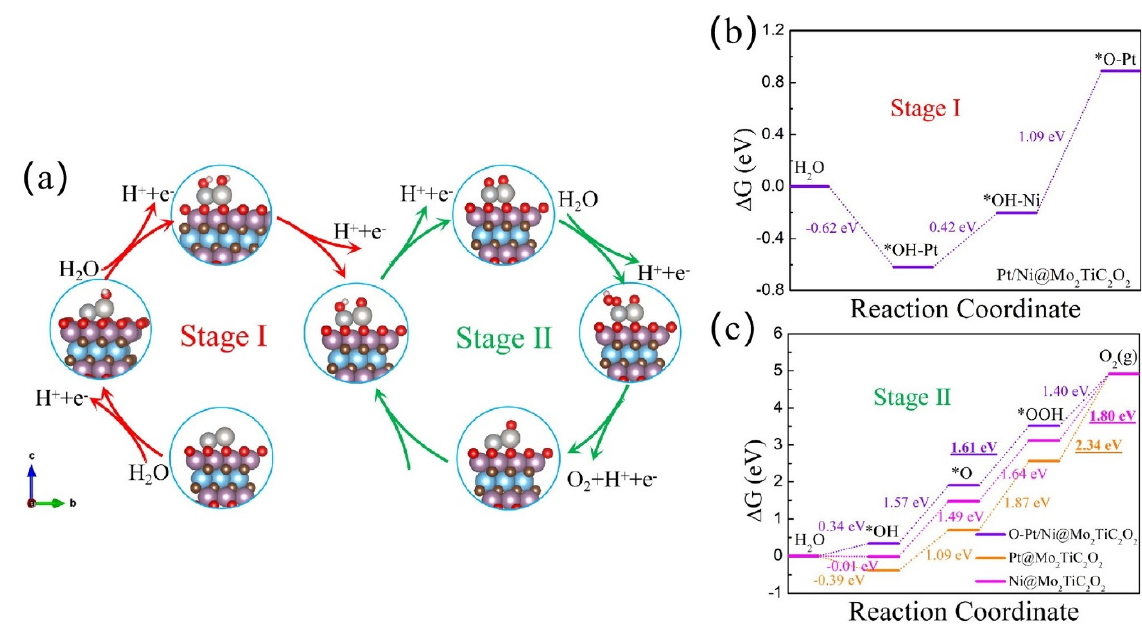
Figure 4. ( a ) The configurations of oxygenated intermediates in energy-favored reaction pathways of OER on Pt/Ni@Mo 2 TiC 2 O 2 h-DACs. The Gibbs free energy diagrams of reaction mechanisms for ( b ) Stage I and ( c ) Stage II and Pt@Mo 2 TiC 2 O 2 SACs and Ni@Mo 2 TiC 2 O 2 SACs. The underlined number represents the most energy-consuming step. The “ ∗ ” symbol represents the adsorption site. a, b and c are the three directional axes of the cell structure, respectively.